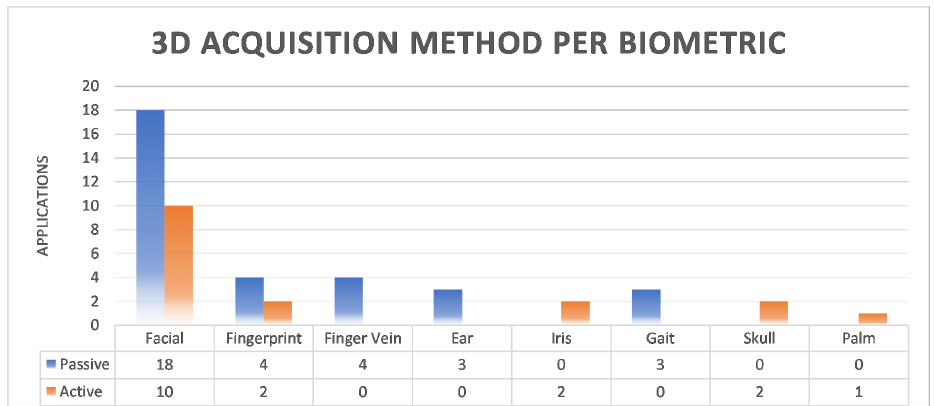
Figure 8. Three-Dimensional (3D) Acquisition Method.